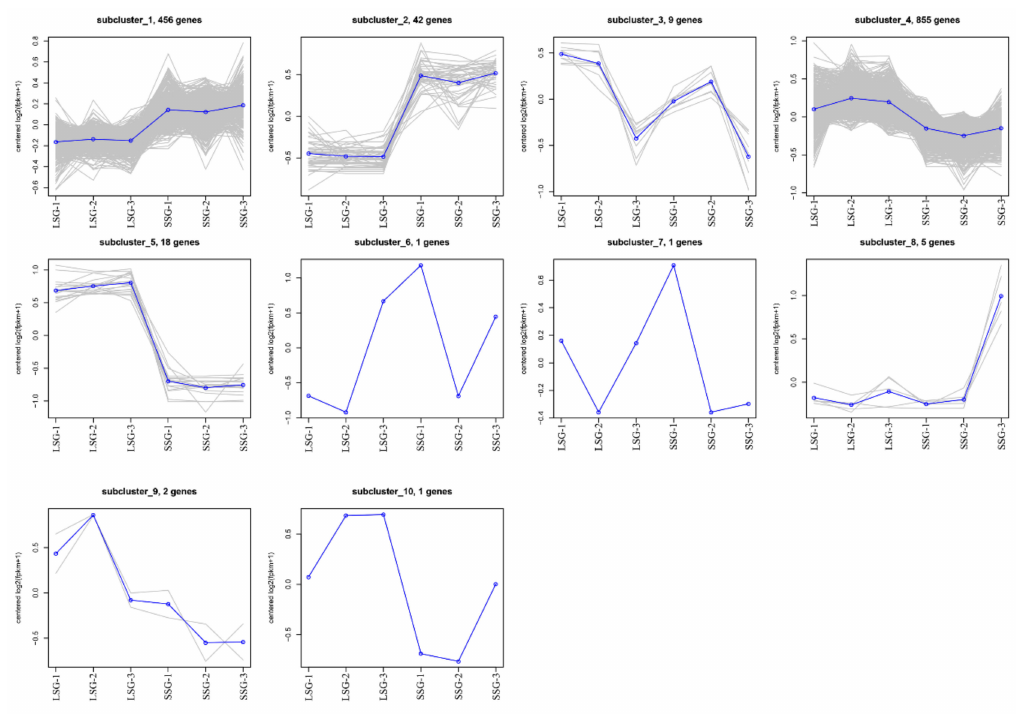
Figure 3. Cluster analysis of the DEGs between LSG and